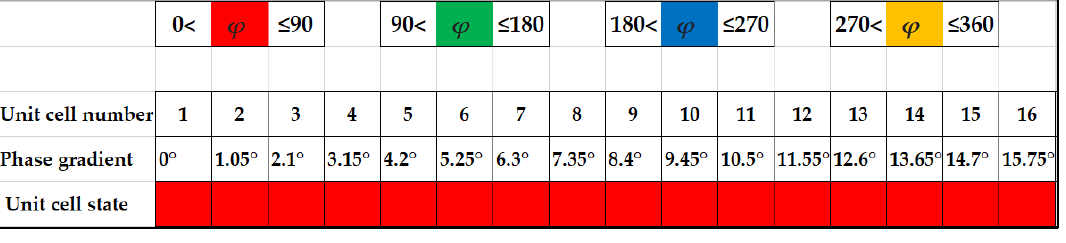
Figure 3. MS phase and state distribution.